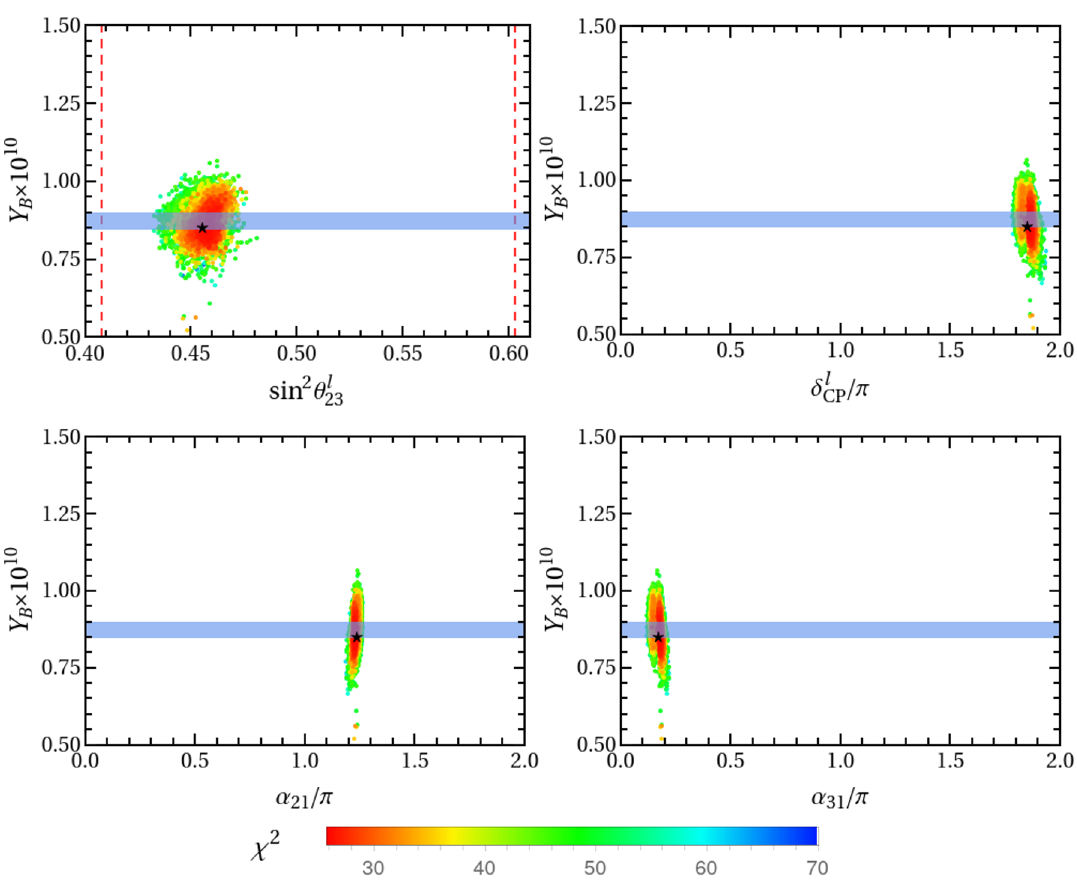
Figure 5 . The numerical results for the correlation between the baryon asymmetry Y B and sin 2 θ l δ l , α 21 , α 31 in the BM2 model with vanishing initial condition. The horizontal band denotes the CP experimentally allowed region of Y B . The star “ F ” stands for the best fitting point in table 3. Note that the contribution of Y B to χ 2 is not included